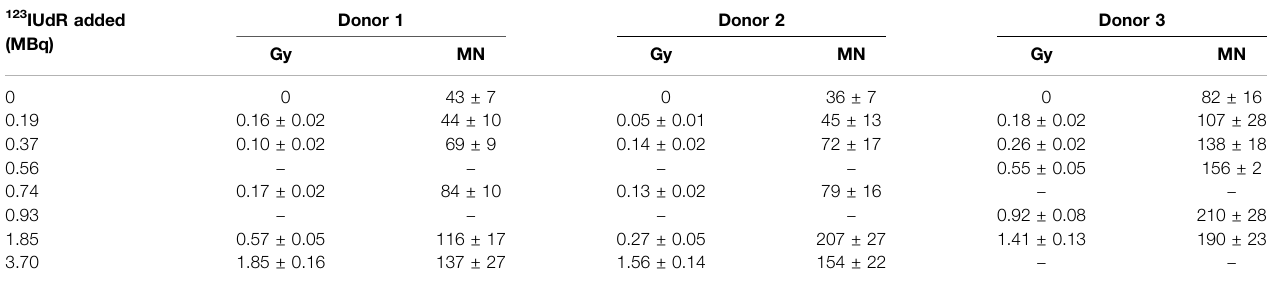
TABLE 1 | The mean absorbed dose (Gy) and mean micronuclei (per 500 BN cells) induced following exposure to different levels of 123 IUdR activity.